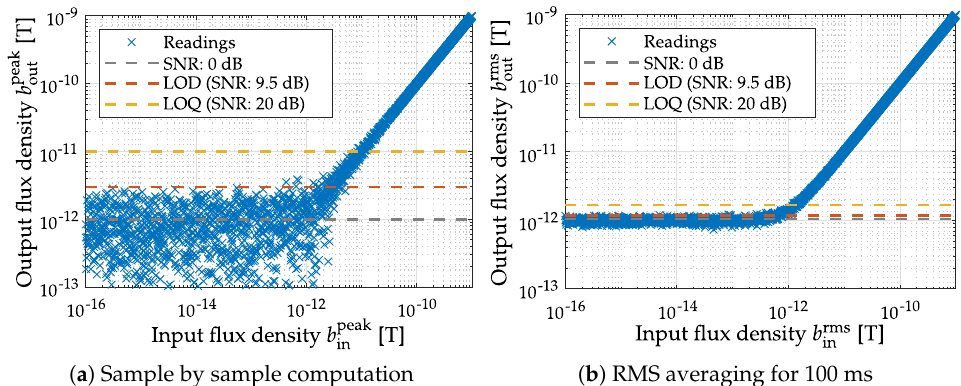
Figure 3. Different methods for LOD computation for the same signal. The simulated sample by sample computation ( a ) of the standard deviation and the mean value yields the same results as the stochastic parameters of the applied random process ( µ n = 0, σ n = 1pT) . The averaging window applied in ( b ) results in a reduced spread and therefore an SNR gain at the cost of a reduction in bandwidth ( µ n = 1pT, σ n =